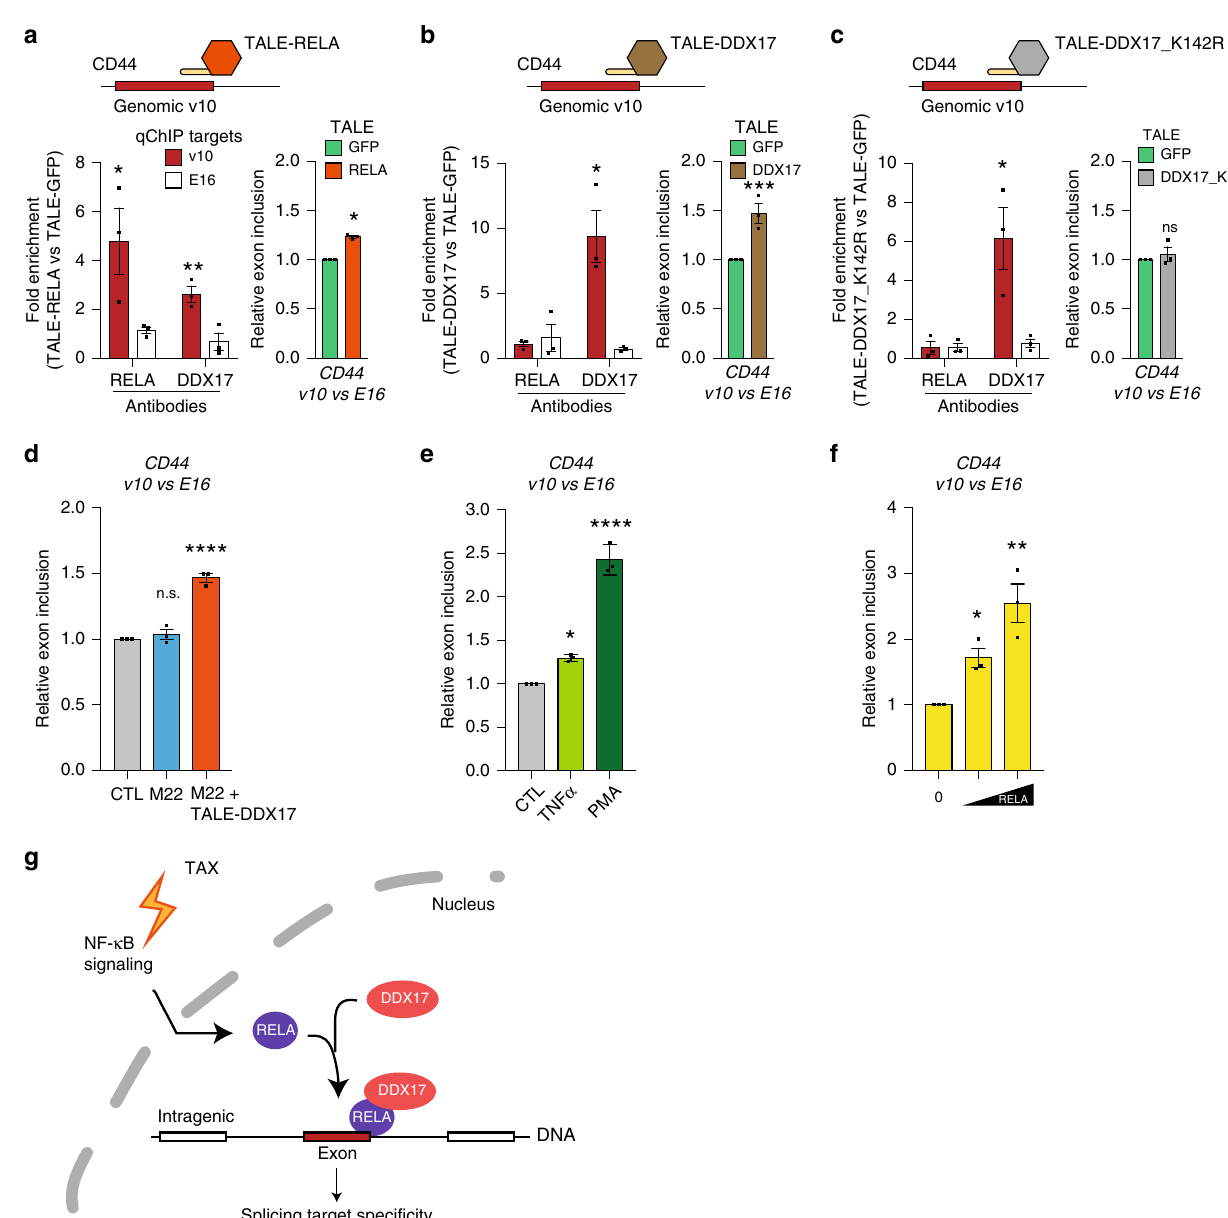
Fig. 6 Chromatin relationship between RELA and DDX17. a – c Chromatin and splicing regulation upon TALE-mediated tethering of RELA and DDX17. The TALE domain was designed to bind the v10 exon of CD44 and fused to either GFP ( a – c ), RELA ( a ), DDX17, ( b ), or a helicase-de fi cient mutant DDX17_K142R ( c ). The effect of TALEs on RELA and DDX17 chromatin enrichment (left panels) and on the relative v10 exon inclusion (right panels) was monitored in HEK cells by qChIP and qRT-PCR, respectively. Results were normalized to measures obtained in TALE-GFP assays. ( d ) Relative exon inclusion rate of exon v10 of CD44 in HEK cells expressing or not the Tax mutant M22 and the TALE-DDX17 construct. e Relative exon inclusion rate of exon v10 of CD44 in HEK cells exposed to TNF α and PMA. f Relative exon inclusion rate of exon v10 of CD44 in HEK cells transiently transfected with increasing amounts of RELA expression vector (200 and 500 ng). g Model of NF- κ B-dependent regulation of alternative splicing. Upon NF- κ B activation, DNA-bound RELA proteins act as chromatin anchors for DDX17, which then provides splicing target speci fi city due to its RNA helicase activity. Data are presented as the mean ± SEM values from biological replicates. Each black square represents a biological replicate. Statistical signi fi cance was determined with two-tailed unpaired t -test (qChIP in a – c ) and one-way ANOVA followed by Fisher ’ s LSD test (relative exon inclusion (REI) in a – f ) (* p < 0.05, ** p < 0.01, *** p < 0.001, **** p < 0.0001). In a – c , exact p -values for TALE-RELA vs TALE-GFP on V10: 0.049 (qChiP RELA), 0.0079 (qChIP DDX17), 0.0276 (REI). Exact p -values for TALE-DDX17 vs TALE-GFP on V10: 0.0139 (qChIP DDX17), 0.0276 (REI). Exact p -values for TALE-DDX17_K142R vs TALE-GFP on V10: 0.0312 (qChIP DDX17). In d – f , exact p -values are <0.0001 (M22 + TALE-DDX17 ( d )), 0.0125 (TNFa ( e )), <0.0001 (PMA ( e )), 0.0369 (0.2 µ g ( f